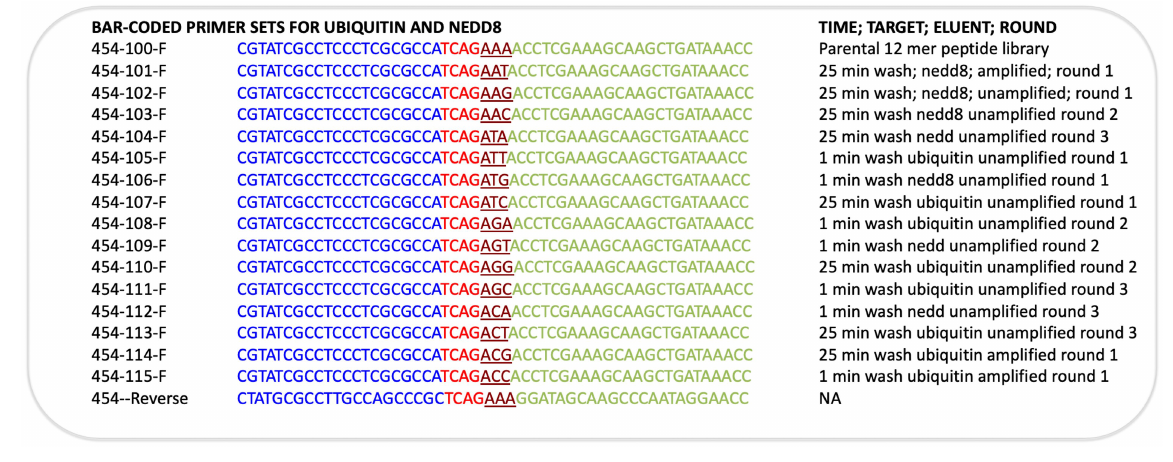
TABLE 1 A summary of the sequences of the primers used for amplifying each phage peptide pool.